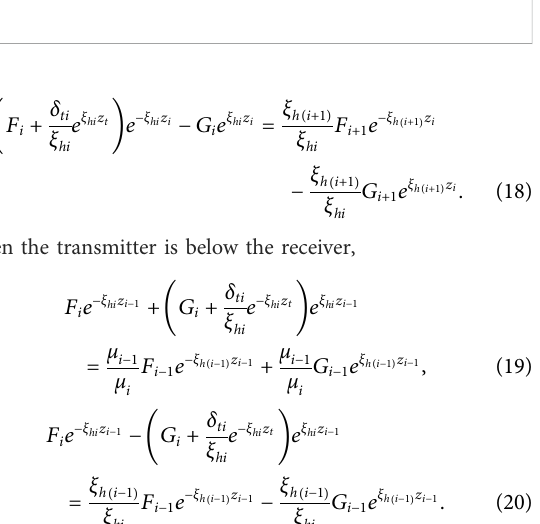
FIGURE 2 Model of the 1D N-layer horizontal layered